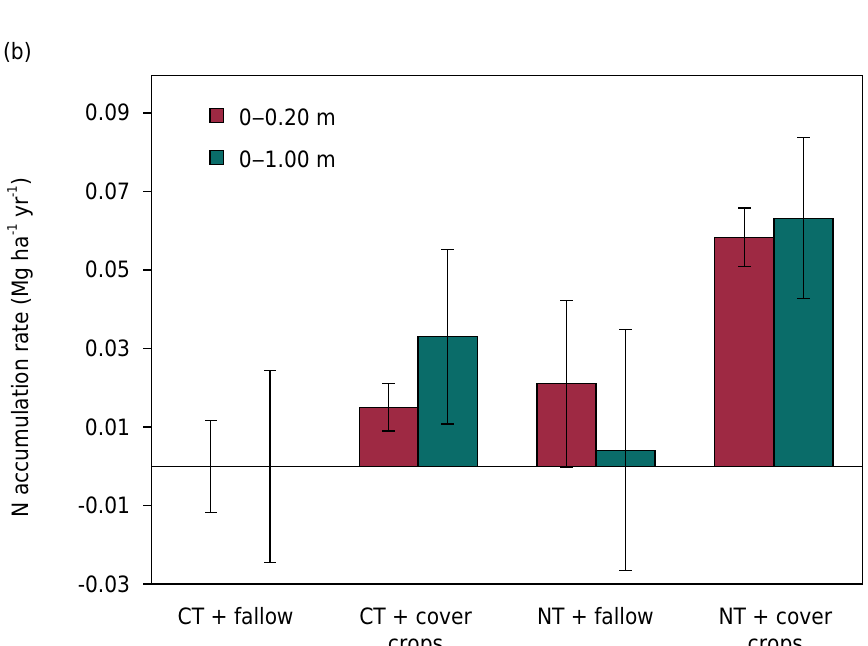
Effects of winter treatments